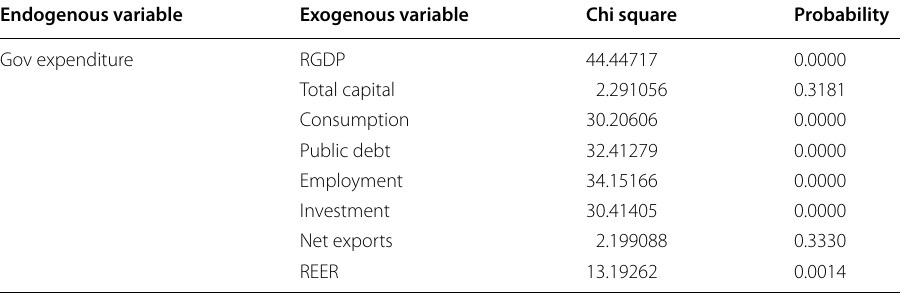
Table 12 Wald test results for Eq. (8). Source : Author’s calculations Endogenous variable